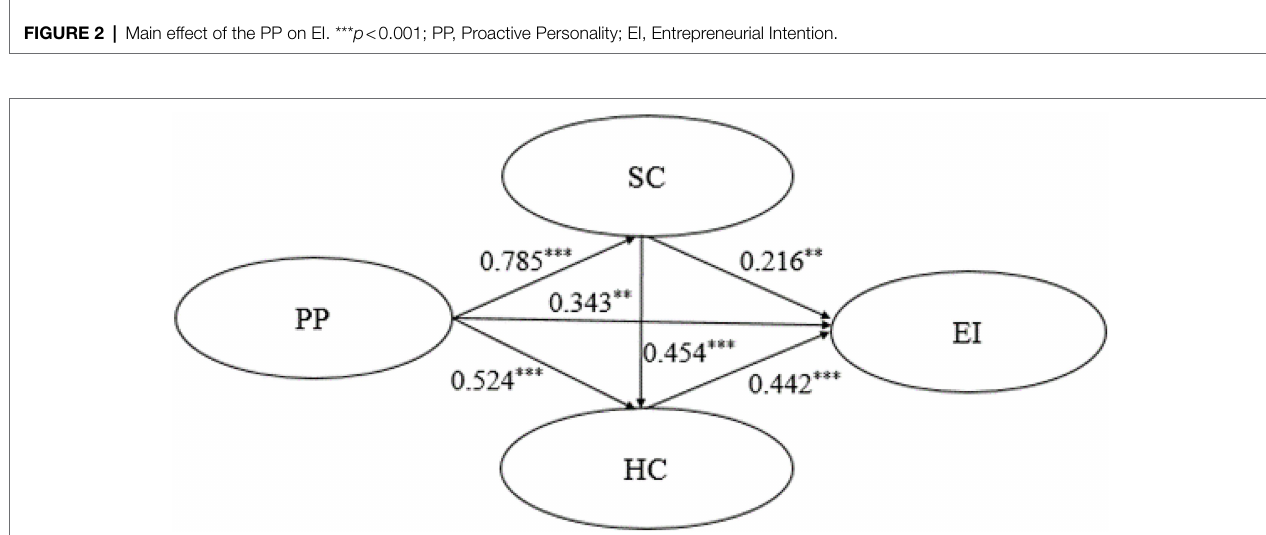
FIGURE 3 | The chain mediation model. ** p < 0.01; *** p < 0.001; PP, Proactive Personality; EI, Entrepreneurial Intention; SC, Social Capital; and HC, Human